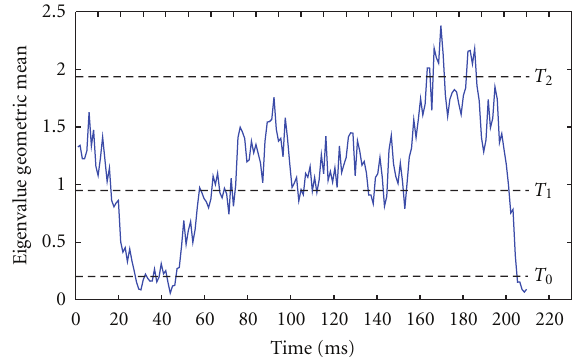
Figure 1: An example of Markov state quantization. The time- varying eigenmodes geometric mean process in a (2,2) MIMO channel is partitioned into S = 4 states using three threshold levels: T 0 , T 1 , and T 2